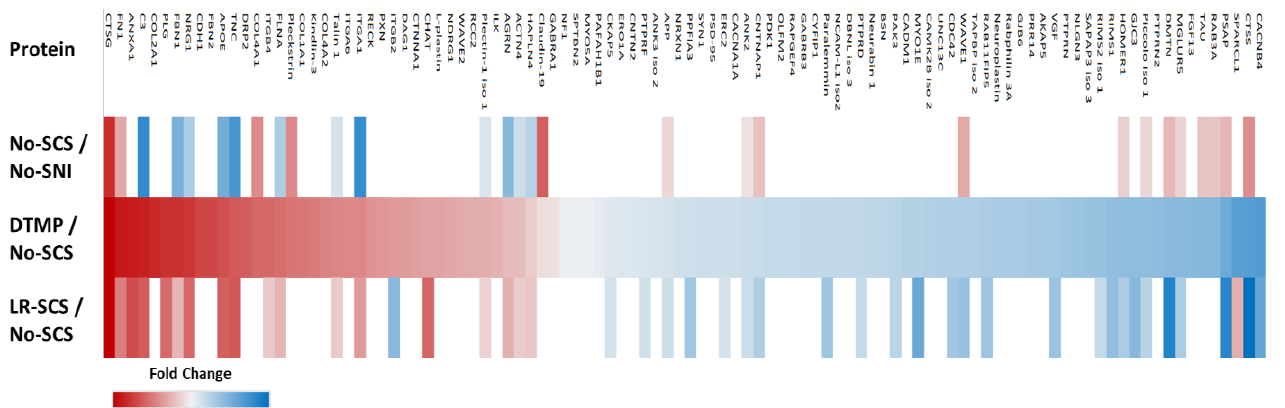
Figure 2. Fold-change (FC) heatmap of the ECM cell junction proteins (n = 112). Red (decrease) and blue (increase) represent significantly changed expression levels, and white stands for no significant change.